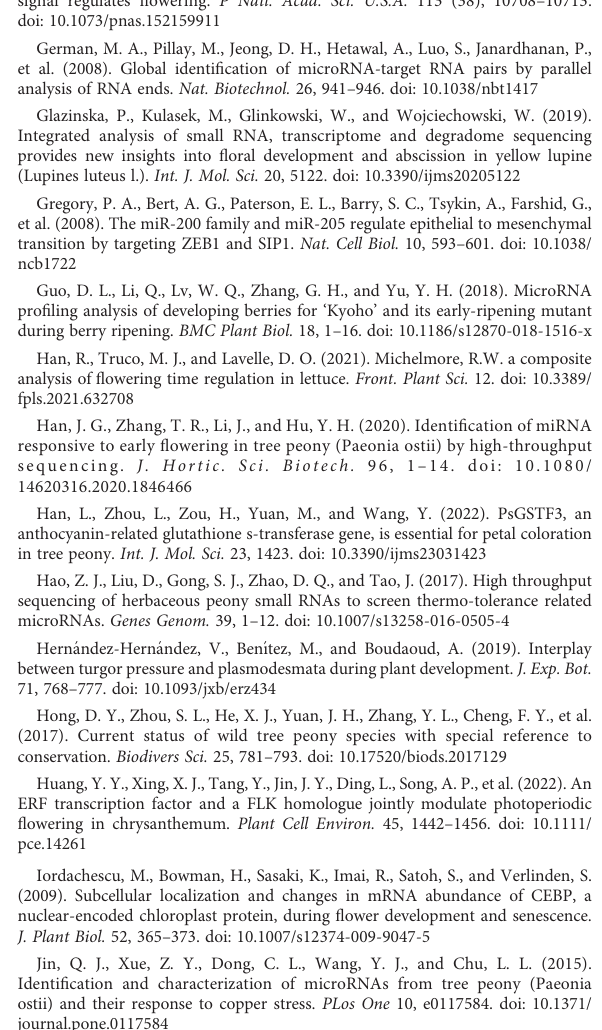
SUPPLEMENTARY FIGURE 5 Summary of the number of genes showing signi fi cant differential expression at different fl ower developmental stages in FD, MU, and LH. (A) Number of genes showing signi fi cant differential expression ( P <0.05) across different fl ower developmental stages (BS, IF, FB, DE) in tree peony variety FD, MU, and LH, respectively. (B) Number of genes showing signi fi cant differential expression ( P <0.05) across varieties (FD, MU, LH) at different fl ower developmental stages (BS, IF, FB, DE), respectively. The blue colored bars represent the number of upregulated genes. The red colored bars represent the number of downregulated genes. SUPPLEMENTARY FIGURE 6 T plot of mRNA-miRNA pairs selected and veri fi ed by qRT-PCR. (A) T plot of MIR11025-p5 and psu.T.00024044 . (B) T plot of miR166-5p and